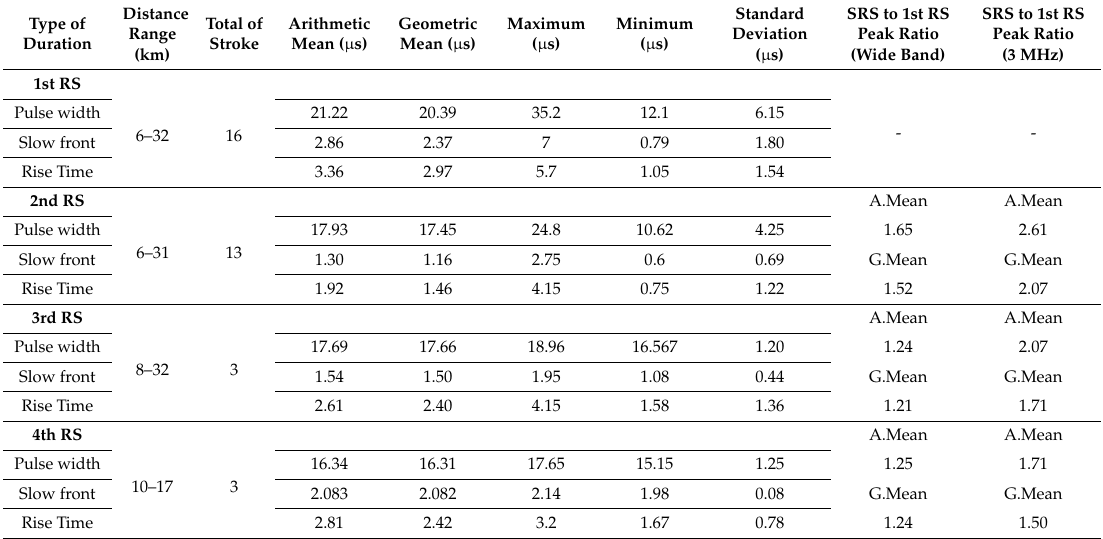
Table 7. Statistics of SRS having higher peak values than the first RS, distance to strike location is shown.